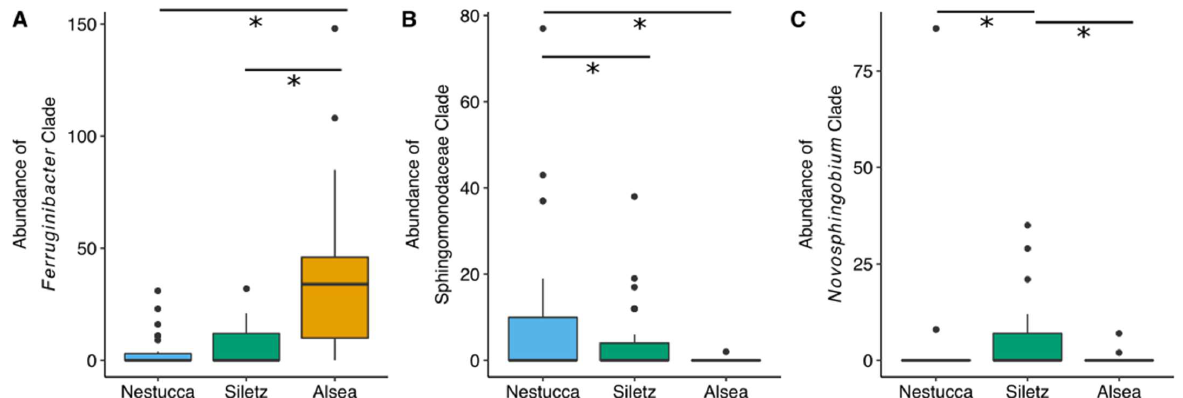
Figure 3. Examples of bacterial clades that are more abundant in each of the three river basins sampled in the geography study. Boxplots visualizing the abundance of steelhead gut microbiome bacterial clades across three western Oregon river basins. Asterisk (*) indicates a statistically significant result using Kruskal-Wallis tests and false discovery rate multiple test correction. ( A ) shows one clade’s abundances from the genus Ferruginibacter , ( B ) from the family Sphingomonadcaeae, and ( C ) from the genus Novosphingobium.